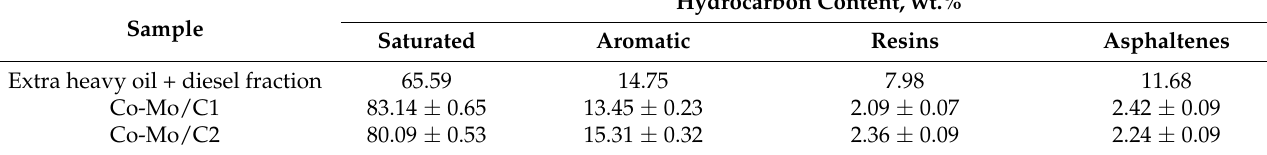
Table 4. SARA fractions.